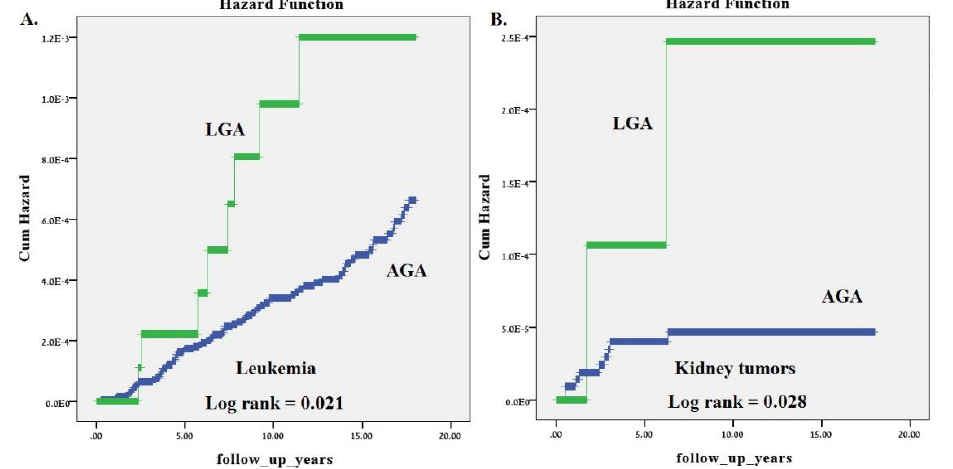
Figure 1. Cumulative childhood malignant tumors according to whether there were LGA or not during index pregnancy. ( A ) Total neoplasm related hospitalizations, ( B ) childhood malignancy hospitalizations only, and ( C ) benign related hospitalizations only.